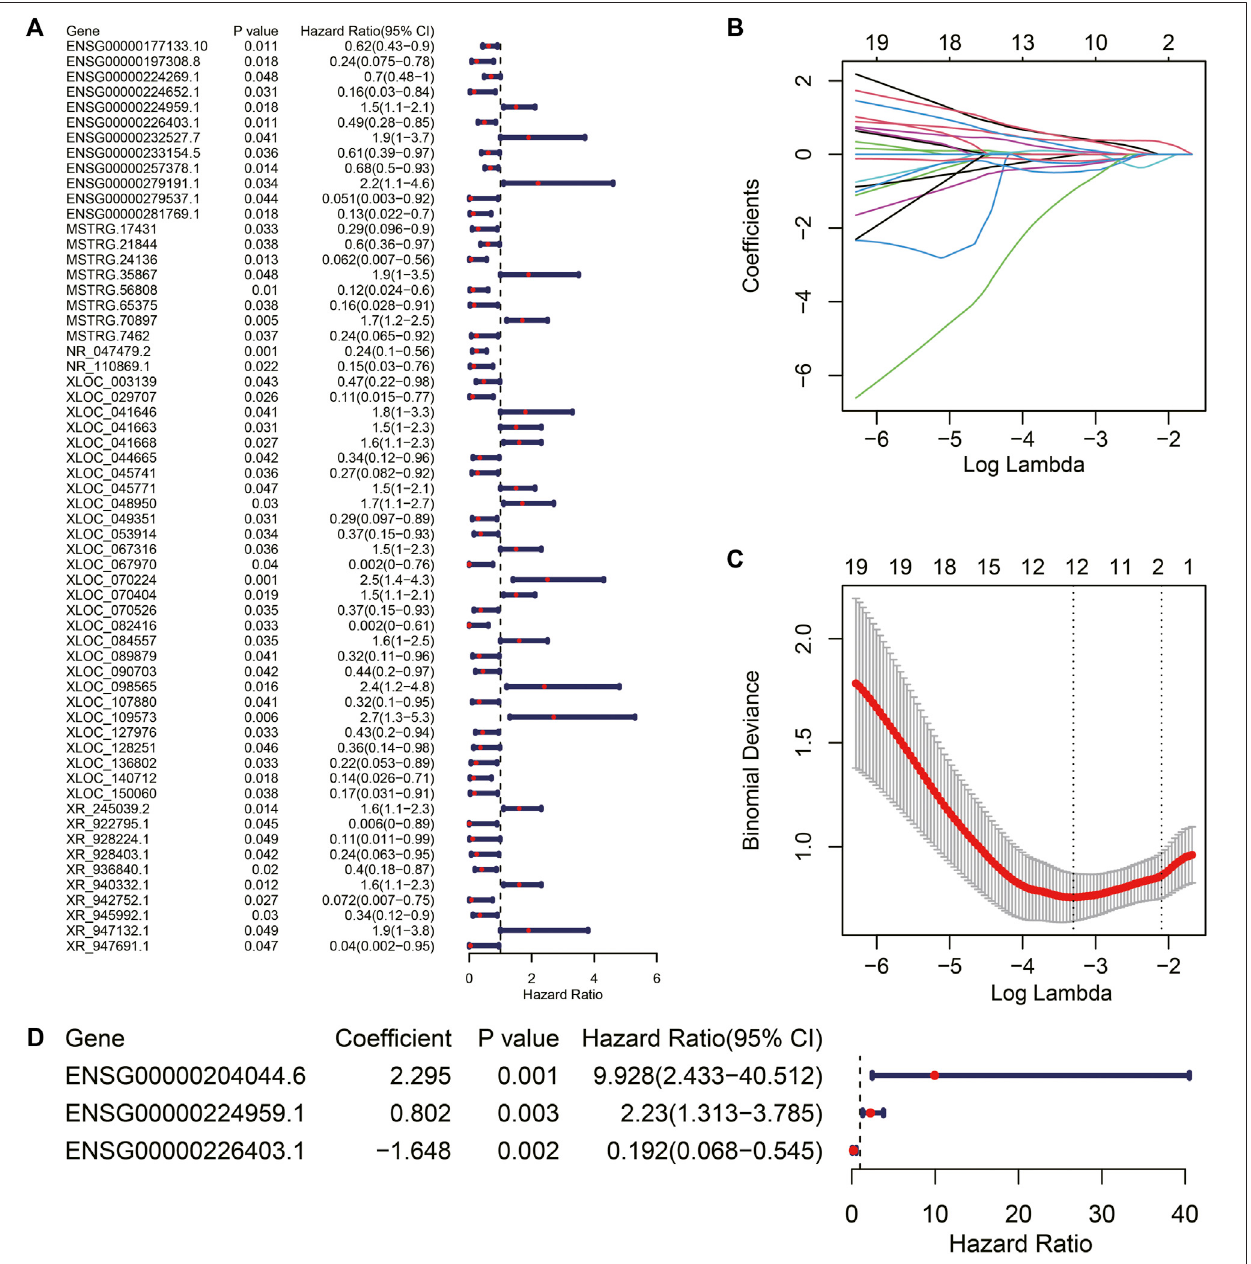
FIGURE 7 | Construction of TIR-lncRNA signature in RCC. (A) The Forest plot showed the p -value, HR, and 95%CI of prognosis-related TIR-lncRNAs calculated by univariate Cox regression analysis. (B) The distribution plot of the LASSO coef fi cient. Twelve variables were retained when log-transformed lambda equal to -3.31. (C) Twelve variables were retained when the partial likelihood deviation reached the minimum (Log Lambda = -3.31). (D) The Forest plot showed the coef fi cient, p -value, HR, and 95%CI of 3 prognosis-related TIR-lncRNAs calculated by multivariate Cox regression analysis.